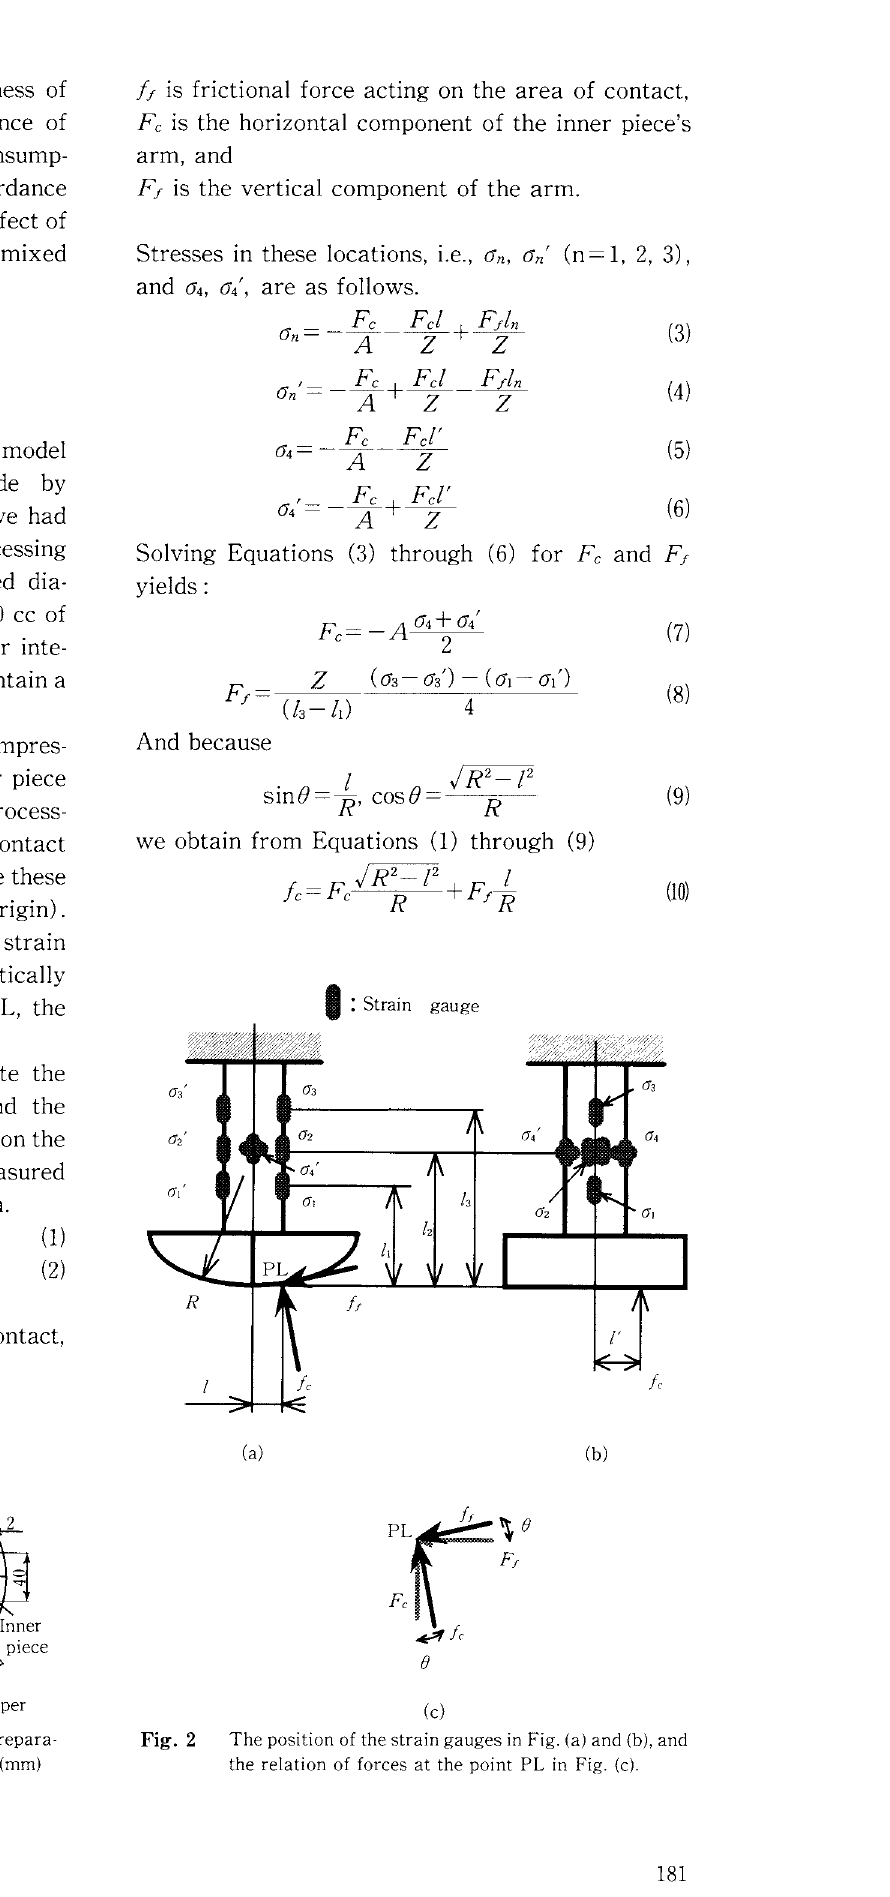
The position of the strain gauges in Fig. (a) and (b). and the relation of forces at the point